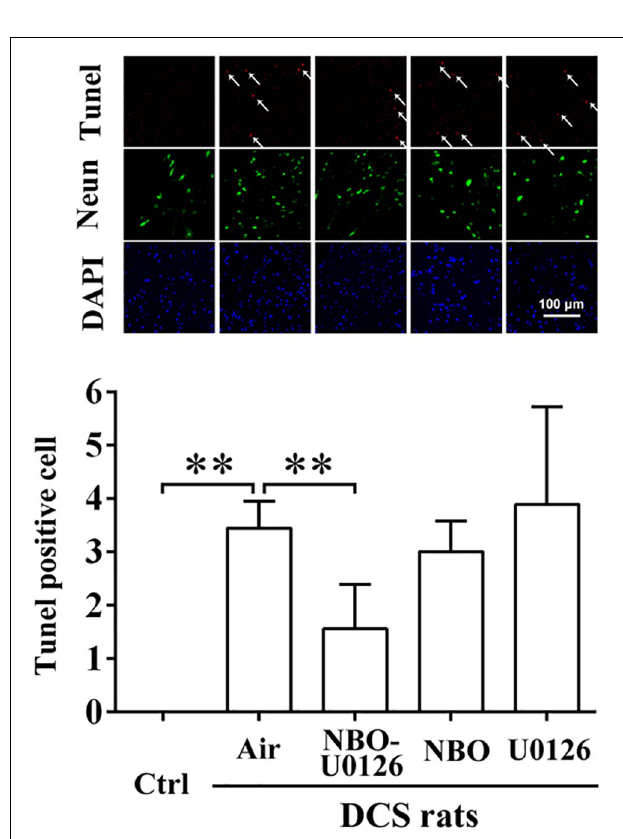
FIGURE 4 | Effect of NBO-U0126 on spinal cord apoptosis in DCS rats. Thoracolumbar spinal cords were sampled from surviving DCS rats at 2 h after simulated air dives, for Tunel/Neun immunohistochemistry to reveal cell apoptosis. Tunel-positive cells are labeled by arrows. ∗∗ P < 0.01. ( n = 6).